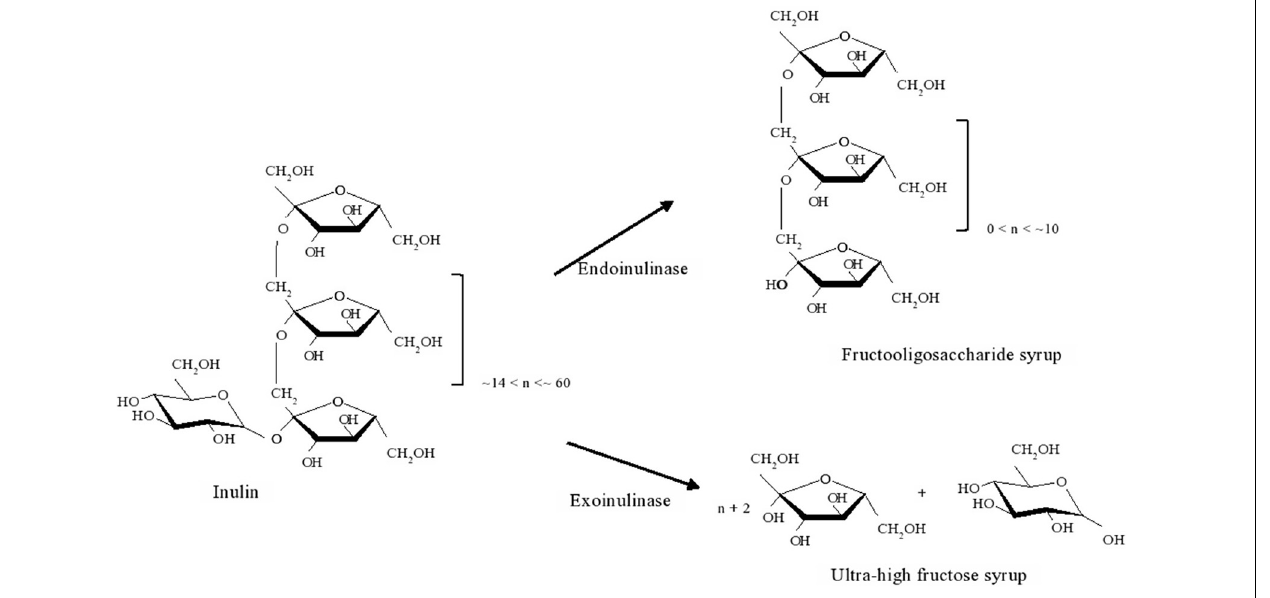
quite uncommon feature for inulinases. The inulinase was also halo-tolerant, for although the maximum activity was observed under 0.5% (w/V) NaCl, it retained about 60% of that activity under 20% NaCl. Regarding temperature, the enzyme displayed a more traditional nature, for activity peaked at 55 ◦ C. Inulin